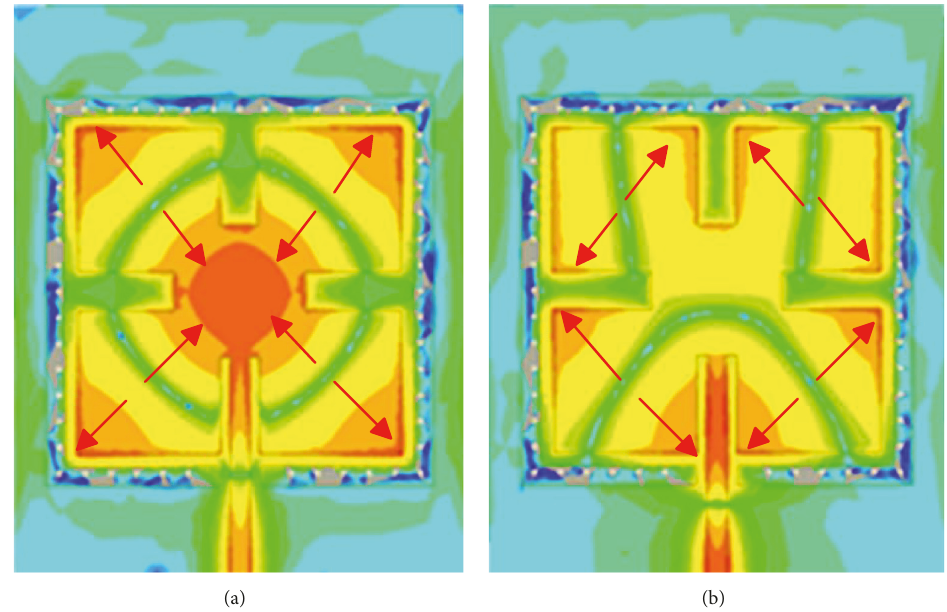
Figure 3: Electric field distribution of full-mode: (a) mode A; (b) mode